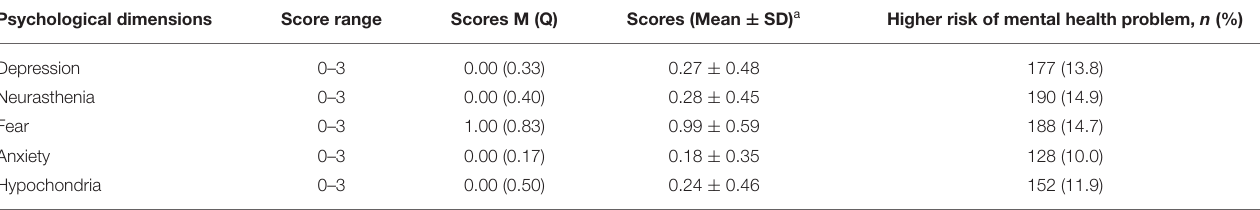
TABLE 2 | Psychological status of Chinese elderly ( N = 1,278).